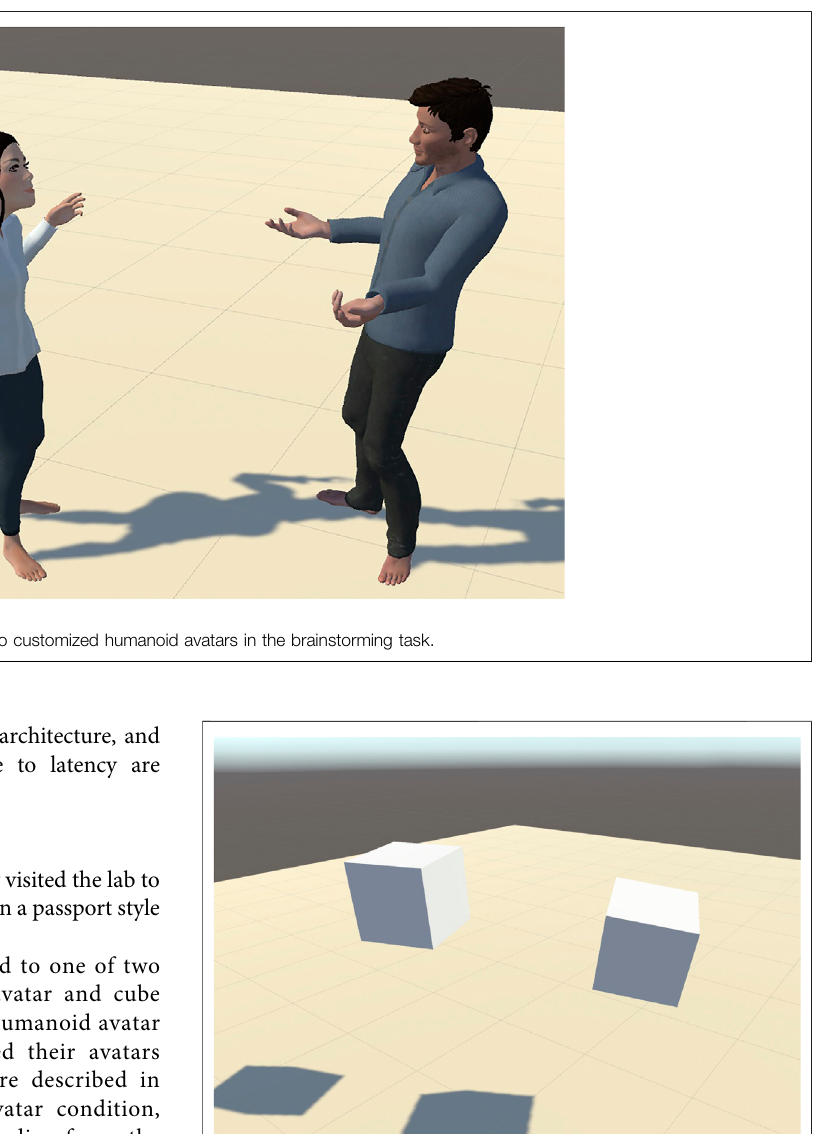
Frontiers in Virtual Reality |